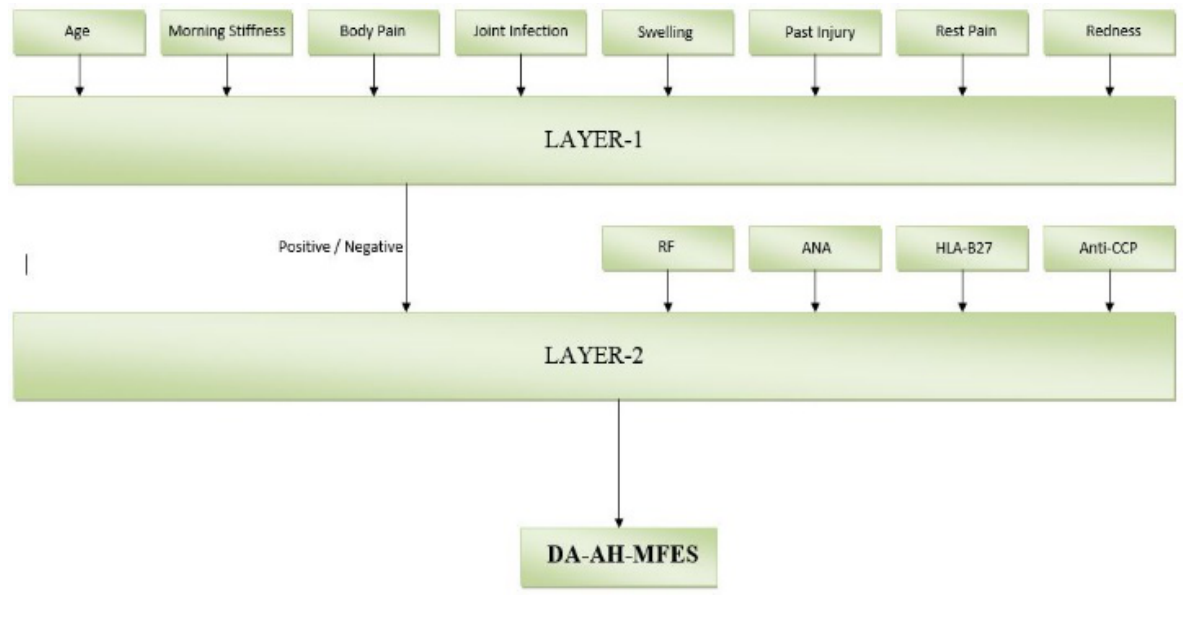
Figure 2. Proposed DA-AH-MFES Expert